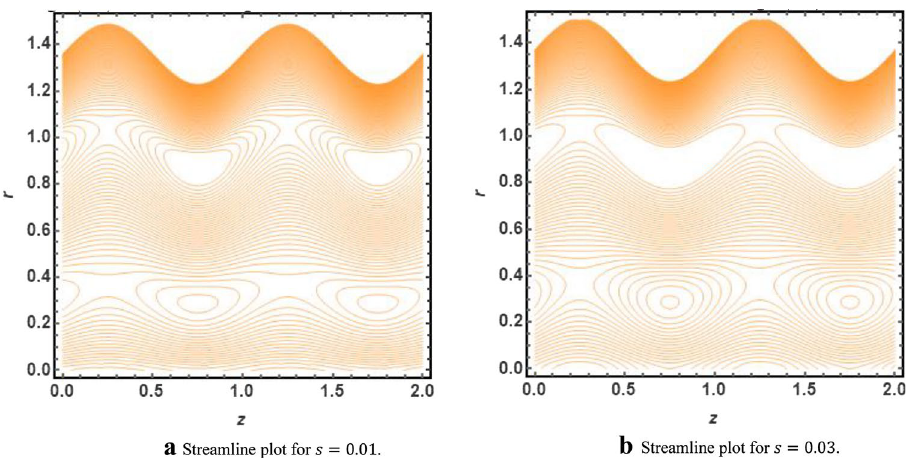
Figure 9. ( a ) Streamline plot for s = 0.01 . ( b ) Streamline plot for s = 0.03